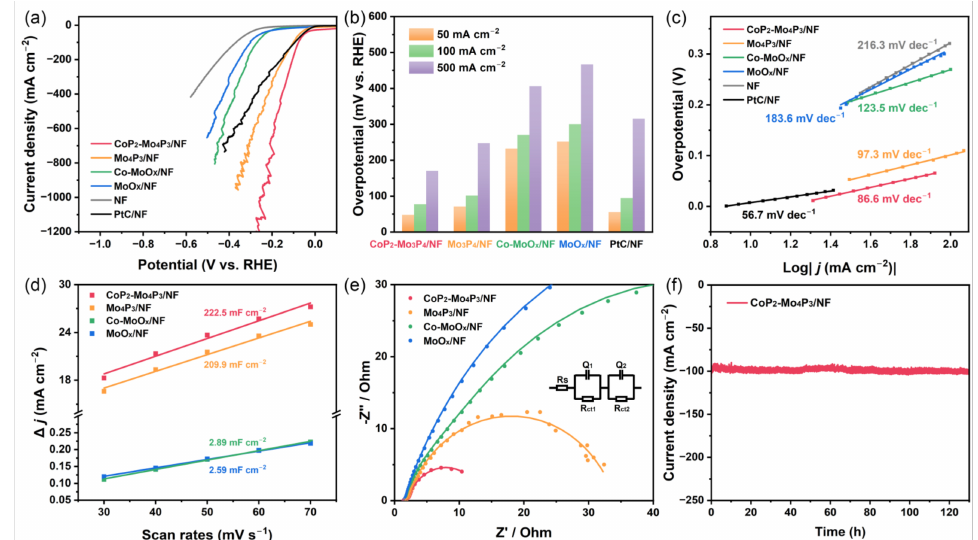
Figure 3. HER performance of synthesized catalysts in 1.0 M KOH: ( a ) LSV curves with iR-correction, ( b ) Overpotentials at different current densities of the obtained samples, ( c ) Corresponding Tafel plots derived from LSV, ( d ) Double-layer capacitance C dl , ( e ) EIS and its fitting patterns, ( f ) Stability measurements of CoP 2 -Mo 4 P 3 /NF catalyst at a current density of 100 mA cm − 2